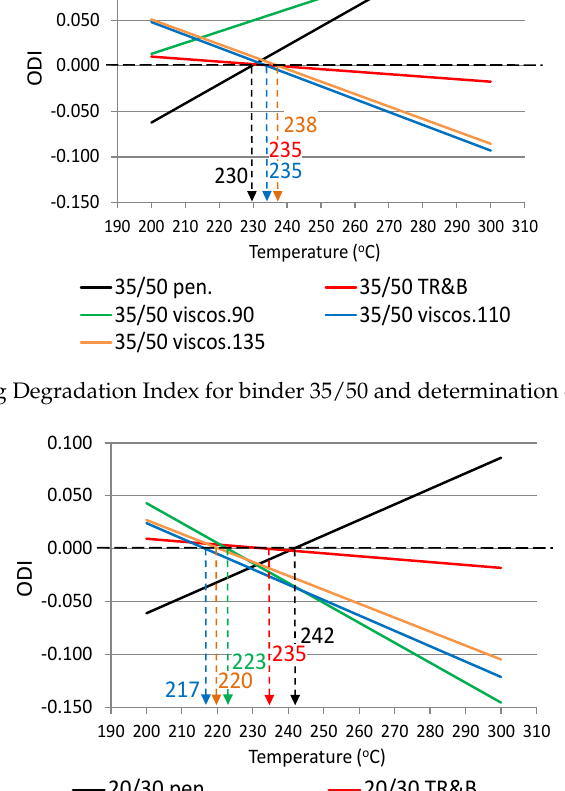
Figure 5. Overheating Degradation Index for binder 20/30 and determination of temperature T (ODI) .